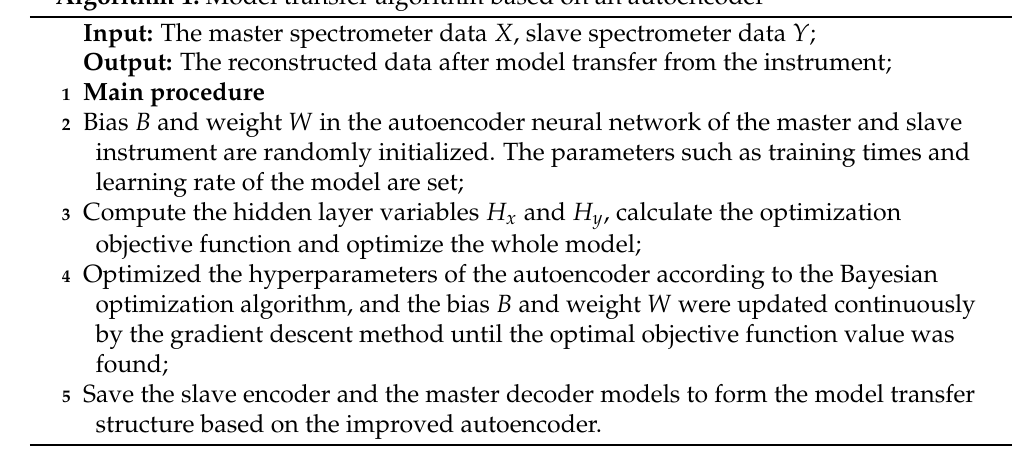
Algorithm 1: Model transfer algorithm based on an